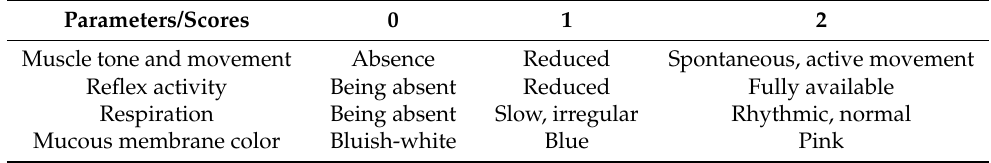
Table 2. Apgar score system modified for newborn calves by Mülling [70]. Parameters/Scores 0 1 2 Muscle tone and movement Absence Reduced Spontaneous, active movement Reflex activity Being absent Reduced Fully available Respiration Being absent Slow, irregular Rhythmic, normal Mucous membrane color Bluish-white Blue Pink